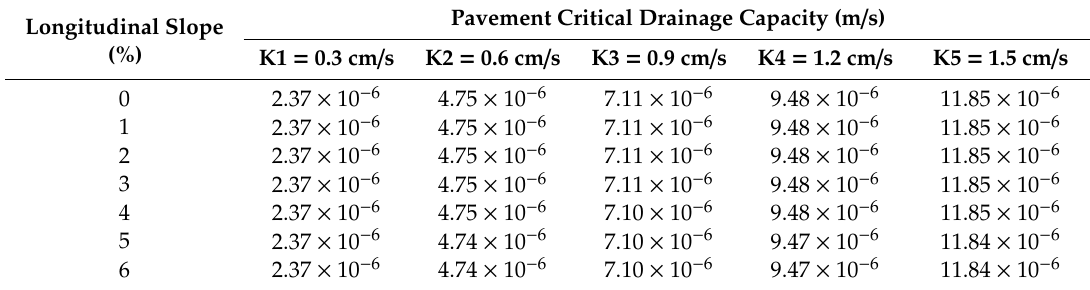
Table 8. Calculation result of the critical drainage capacity of the pavement with di ff erent transverse slopes of 4% for the first boundary condition.